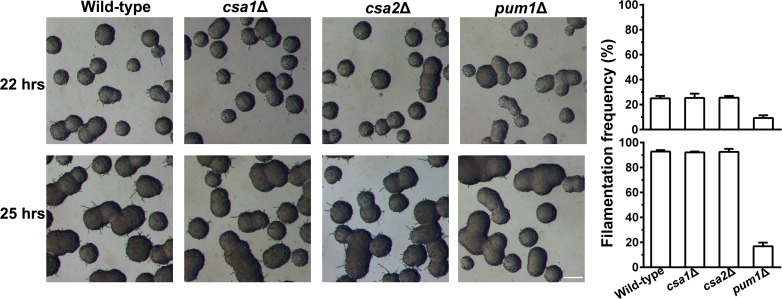
The absence of Pum1 but not its downstream targets Csa1 and Csa2 adversely affected self-filamentation during unisexual reproduction.For quantitative analysis of self-filamentation frequency during unisex, the cells of each strain were plated onto V8 medium at a low cell density and allowed to grow into isolated mini-colonies after 22 hr or 25 hr of culture. Mini-colonies exhibited a great heterogeneity in filamentation (left), and filamentous incidence among mini-colonies reflects the strength of unisexual induction. Filamentation frequency (FF) is the percentage of filamentous mini-colonies. The dynamics in FF during unisexual development in different strains was calculated, respectively (right). n = 3 independent experiments, mean ± SD. Scale bar: 100 μm.10.7554/eLife.38683.015Figure 4—figure supplement 2—source data 1.Source file for Figure 1—figure supplement 1.